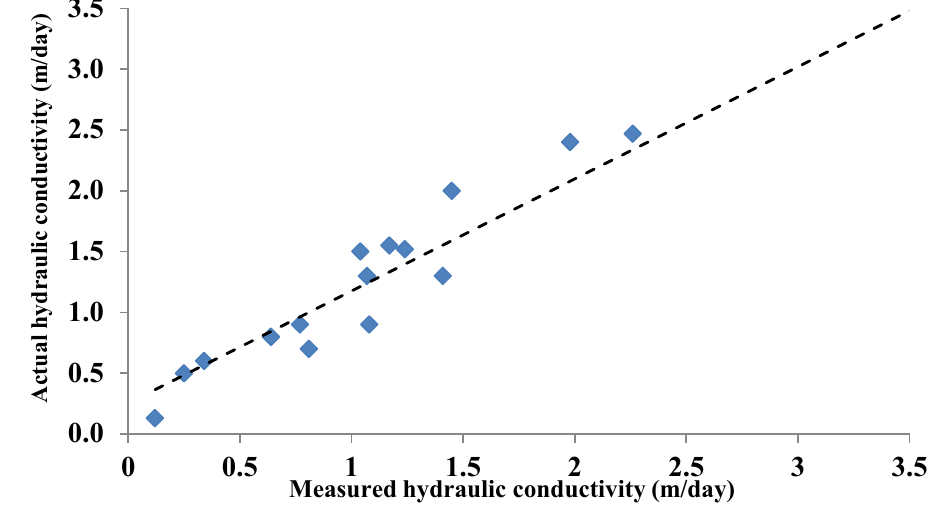
Fig. 8 Cross validation method to analyze simple Kriging method